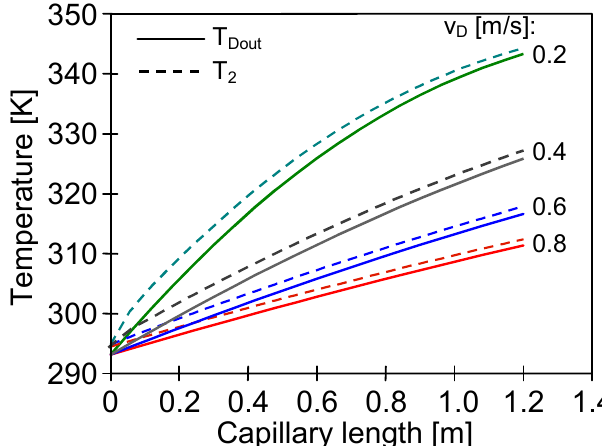
Figure 8. The results of numerical calculations. The influence of distillate flow rate on distillate bulk temperature and temperature of condensation layer (T 2 ). Mode 1: T F = 353 K, T Din = 293 K. Membranes: Accurel PP S6/2, L = 120 cm. Feed flow v F = 0.05 m/s.